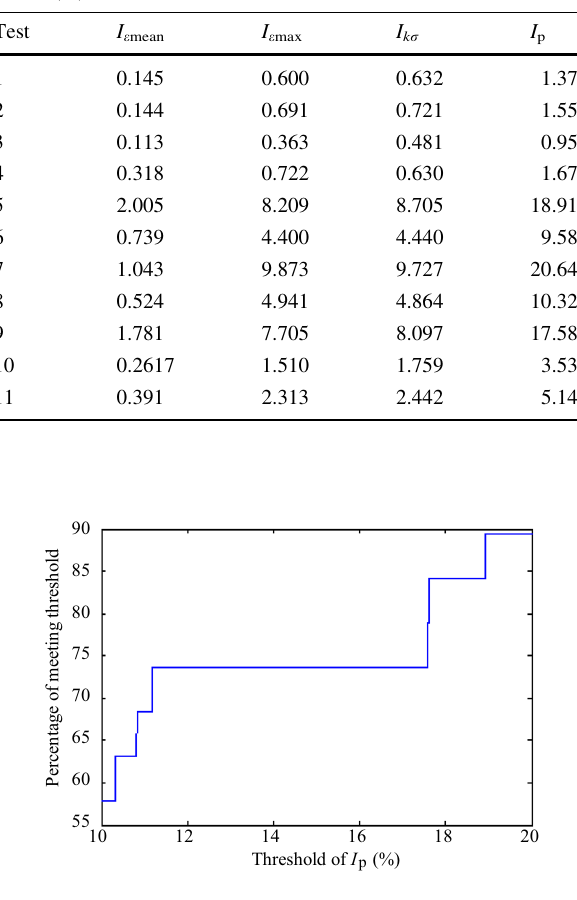
Fig. 4 Threshold versus percentage of meeting the threshold for the 19